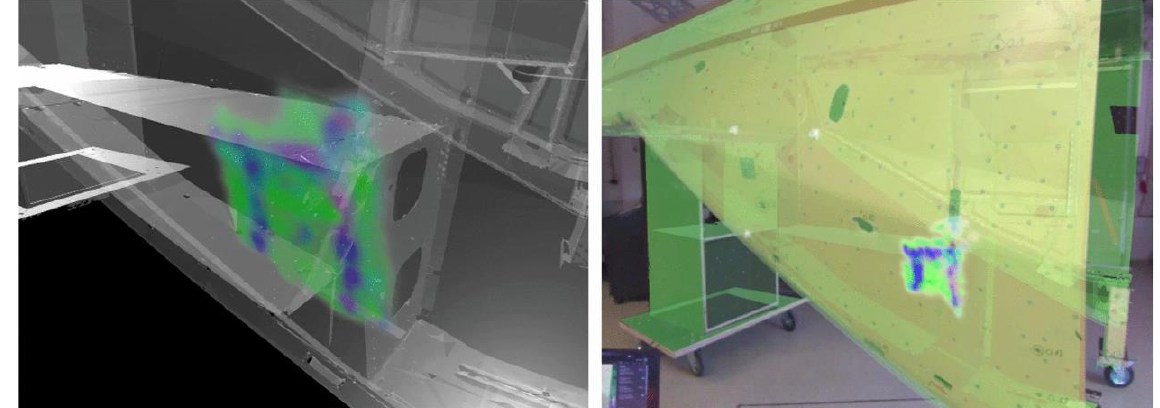
Figure 20. The visualization of the NDT data in VR mode ( left ) and in AR mode ( right ) [123].